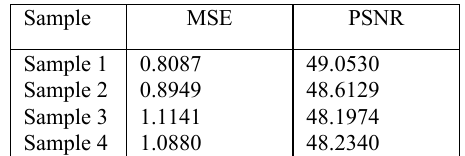
Table 1 . Quantitative results (regular mask) onthree testing